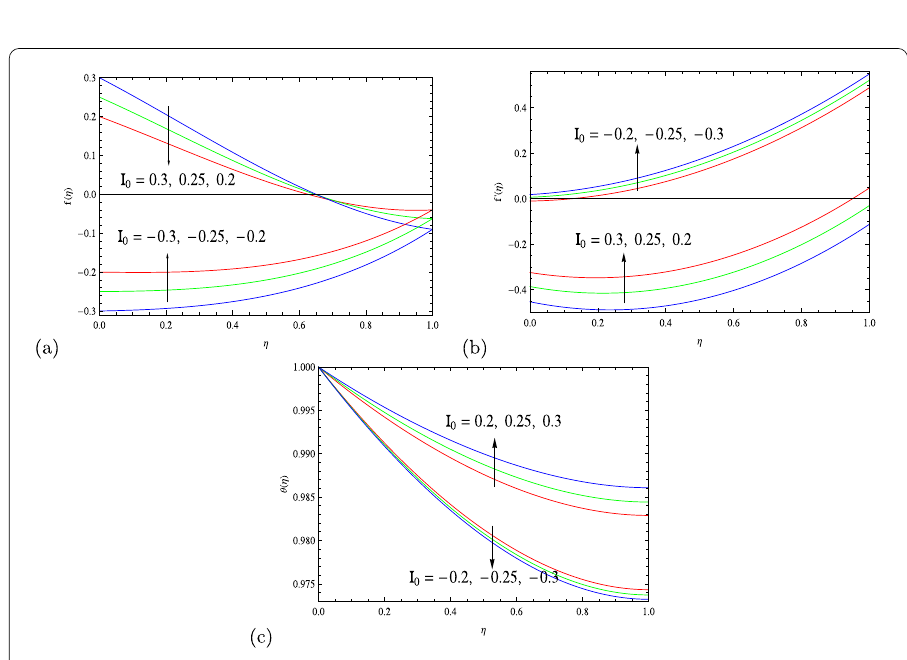
Figure 26 The effect of I 0 on azimuthal velocity, velocity, and temperature profiles with β = 0.2, Pr = 1, λ = 0.2, A = 0.3, N = 0.2, M = 1, Ma = 1, S = 0.4, Υ = 0.127013, Pr = 1